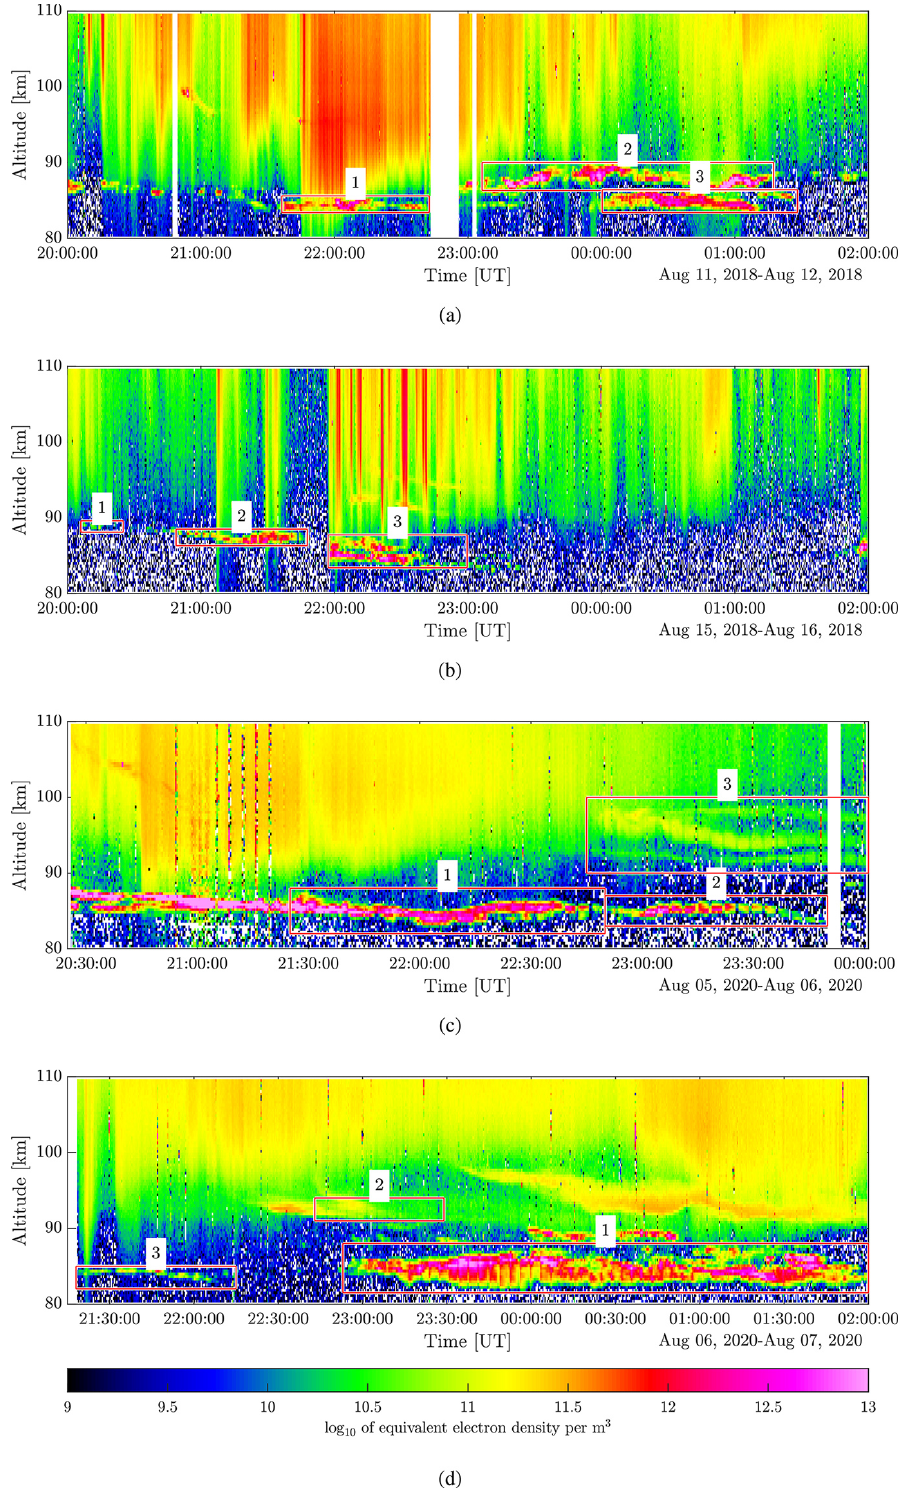
Figure 4. Overview of all four observation days with time intervals and dates given in each respective